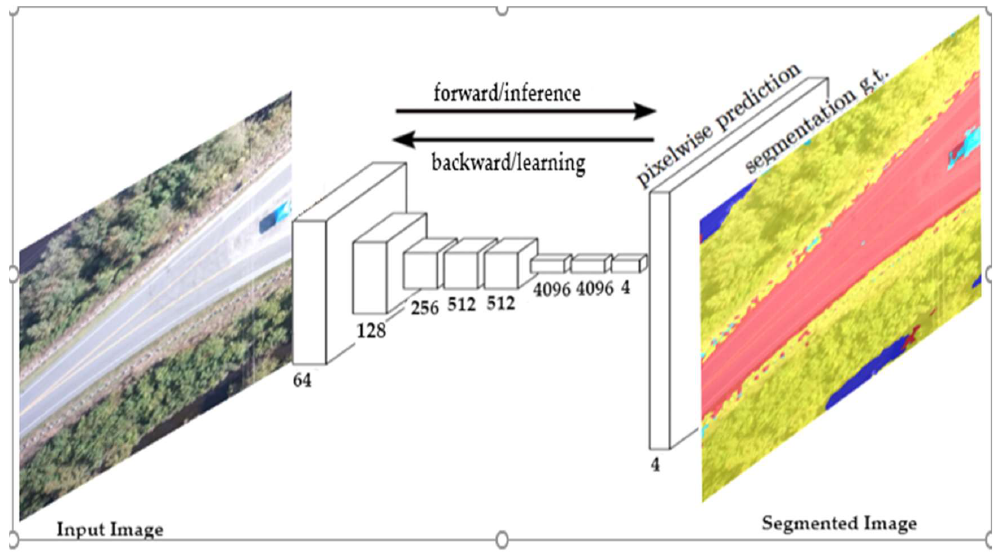
Figure 3. FCN-16s architecture with four classes [19].